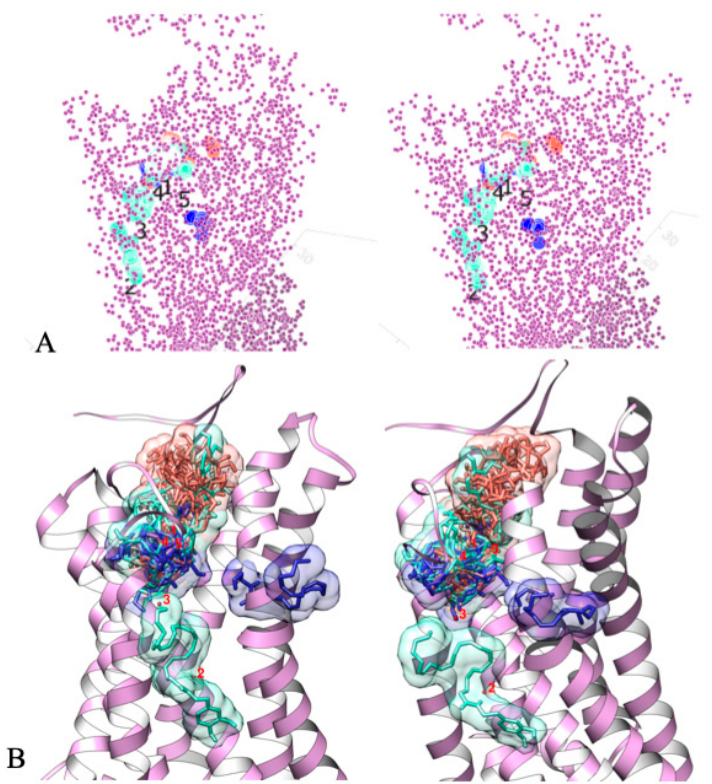
Figure 3. Alternative binding sites of anandamide (AA-EA, blue), lysophosphatydyl inositol (LPI, red), and N -docosahexaenoyl dopamine (DHA-DA, cyan) on GPR55 (shown in purple). Molecular docking results (AutoDock Vina); ( A ) docking result centers and GPR55 atom coordinates, ( B ) some docked ligands on GPR55 ribbon model (same coloring) and cluster numbering.